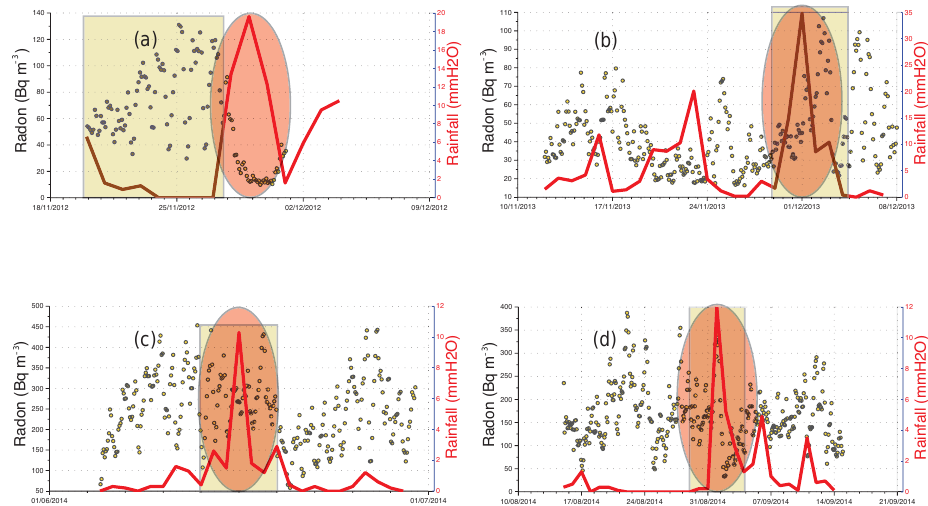
Figure 3. MMNG radon concentration in (Bqm − 3 )/115min (yellow dots) and daily average rainfall (red line) for some significant fall– winter (a, b) and spring–summer (c, d) periods (see text for details). Red ellipses mark heavy rain events, whilst yellow rectangles represent radon concentration